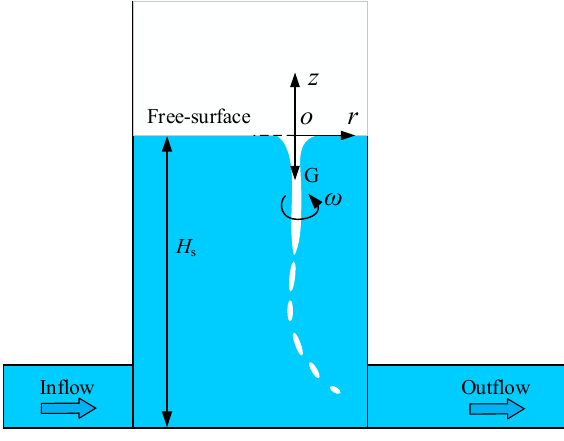
Figure 2. Bottom horizontal suction of underground pumping stations.